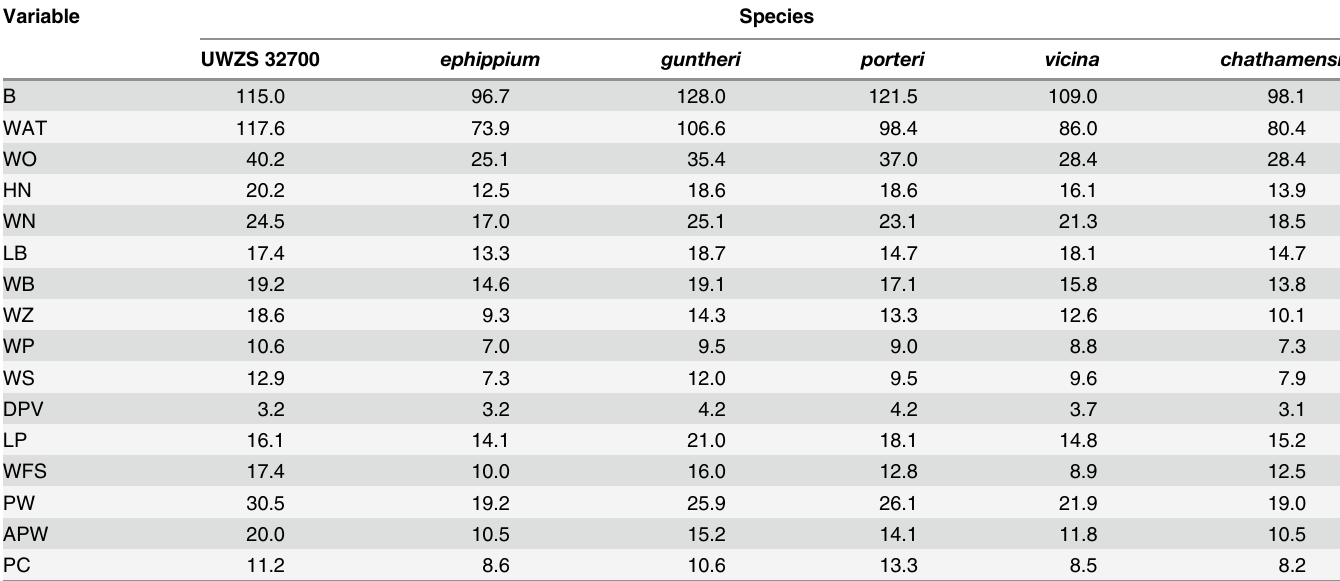
Table 5. Morphometric data for UWZS 32700 compared to data presented in Crumly [53]. Sixteen measurements were taken from the skull of UWZS 32700 following those described by Crumly [53]. Measurements were taken to the nearest 0.01 mm using a Mitutoyo digital caliper. Variable